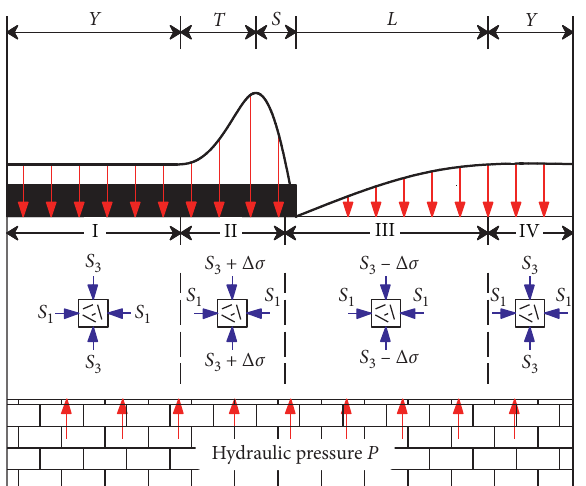
Figure 3: The stress distribution of stope floor along the strike above confined aquifer. Y , original stress zone; T , elastic zone; S , plastic zone; L , stress decreasing